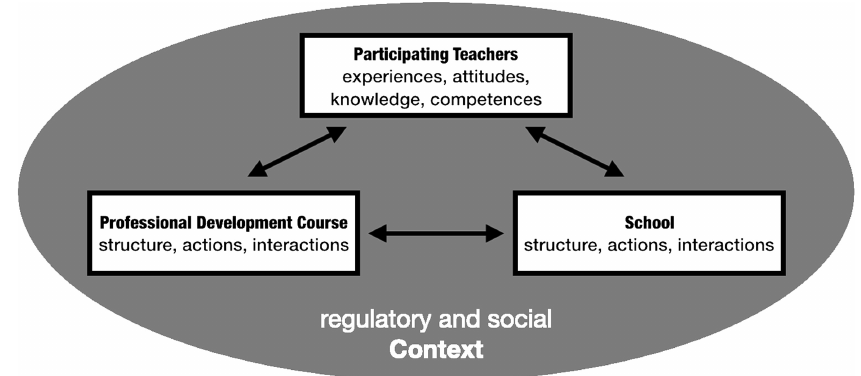
Figure 1. Interactions and influences in PTD. Based on Maxwell ’ s (2010) Conceptual framework for examining LSS trainee